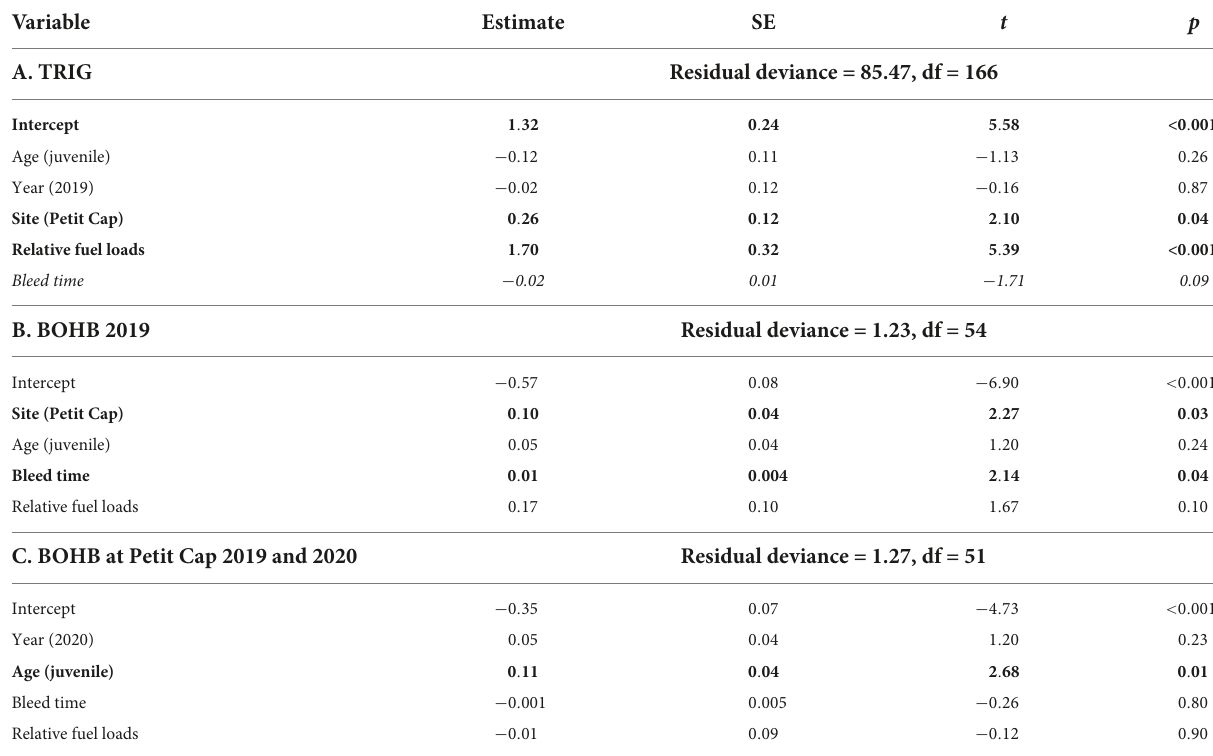
TABLE 3 Generalized linear models analyzing plasma metabolites of all sampled birds. Variable